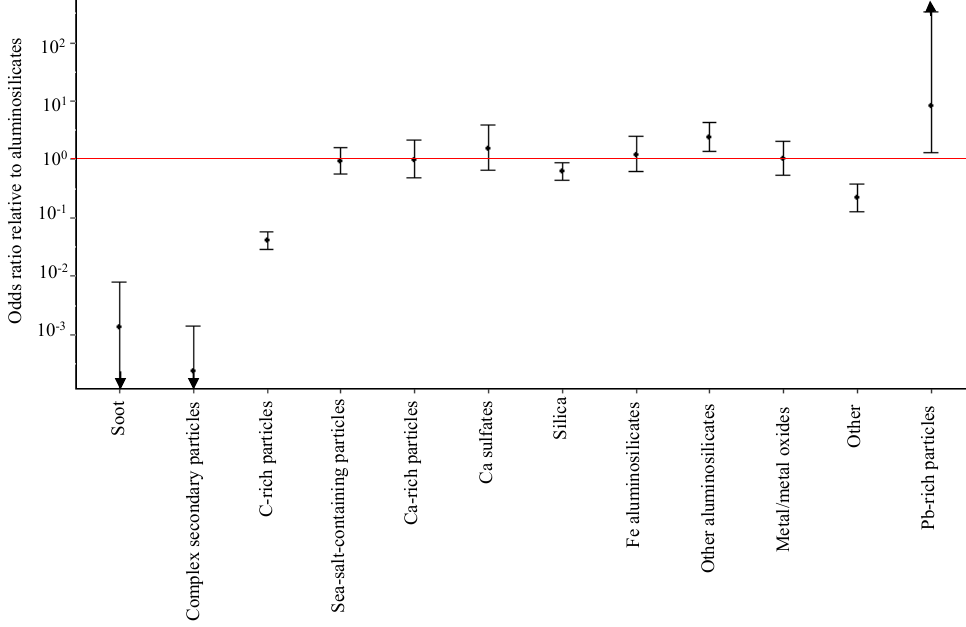
Figure 8. Enrichment or depletion of the different particle groups within the IR fraction expressed as the odds ratio (see text for details). The 95% confidence interval (CI) of the odds ratio is shown as error bars. For soot and complex secondary particles the lower limit of the CI, and for Pb-rich particles the upper limit of the CI, cannot be defined precisely due to counting statistics. Thus they are marked by